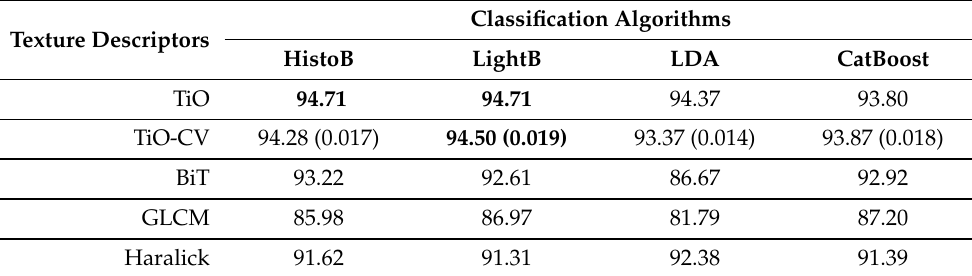
Table 6. Accuracy (%) of monolithic classifiers and ensemble methods with TiO and each descriptor employed individually on the test set of the CRC dataset. TiO (CV) represents the average accuracy and standard deviation (%) on a 10-fold cross-validation setup. The best results are shown in